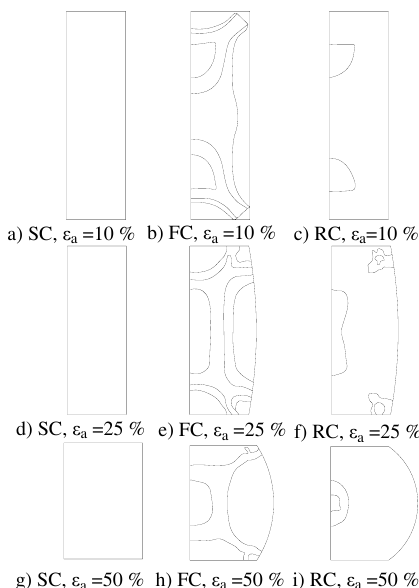
Fig 1 . Distribution of effective axial stress a σ ′ (kPa) in specimens for drained tests